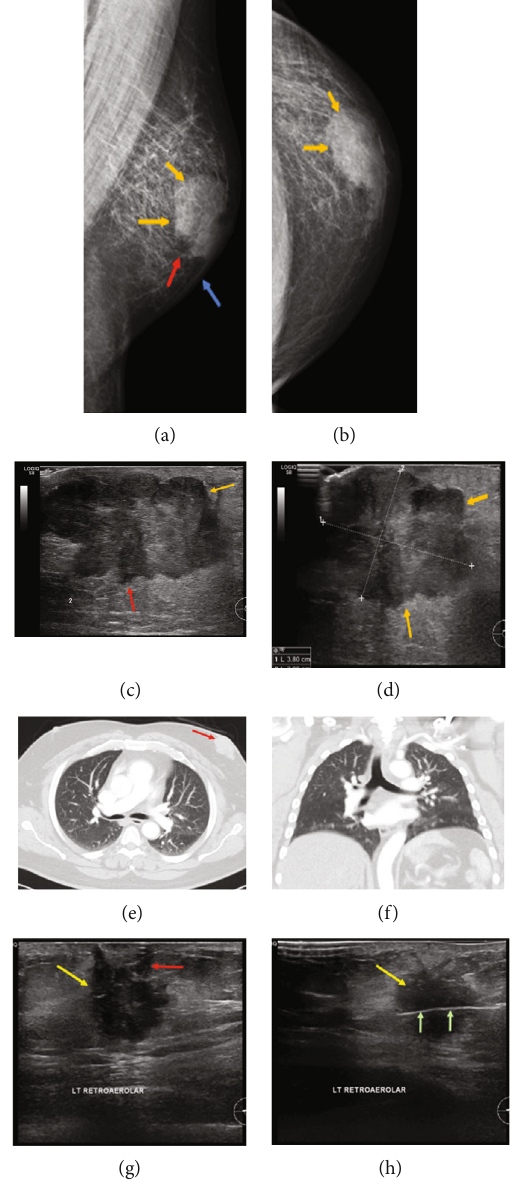
Figure 3: Left mammogram, ultrasound of the left breast, and chest CT of a male patient with malignant breast cancer. (a) MLO view and (b) CC view, showing a large dense mass (yellow arrow) in the retroareolar and upper location. The mass has irregular margins with adjacent coarse trabeculae (red arrow) and mild skin thickening (blue arrow). No microcalci fi cation or skin retraction was observed. (c, d) Complementary ultrasound of the left breast revealed a huge mass (yellow arrow) with lobulated contours and heterogenous echoes. The lesion measured ~ 3 : 8 × 3 : 0 cm, was located at 1-2 o ’ clock position, and appeared to invade the adjacent parenchyma (red arrow). (e) CT images (lung window) of the fi rst case showing a mass of the left breast (red arrow). (f) There was no evidence of metastasis to the lungs or mediastinum. (g, h) Show the ultrasound-guided left breast biopsy of the second malignant case. (g) A huge hypoechoic mass (yellow arrow) with lobulated contours. This is located at 1 to 2 o ’ clock position and appears to be invading the adjacent parenchyma (red arrow). (h) Shows the tumor mass (yellow arrow) and biopsy needle (green